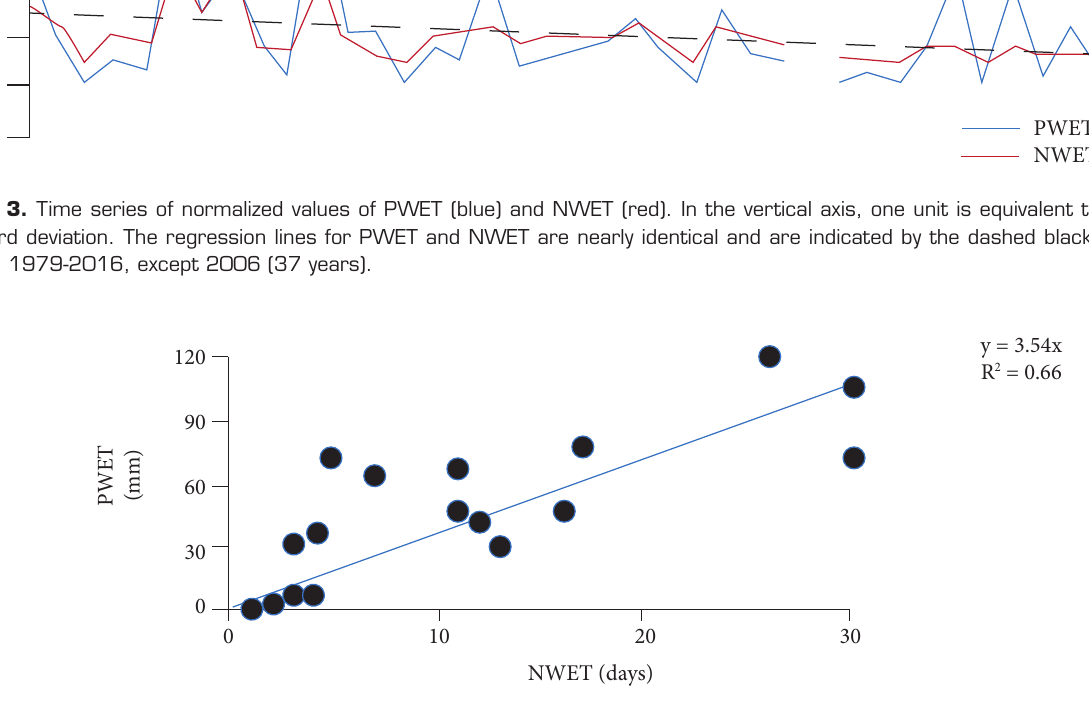
Figure 4. Dispersion diagram for the values of NWET and PWET. Each circle refers to one year. The regression line considering the intercept = 0 is drawn in blue. The regression parameters are shown at the upper-left corner. Period: 1979-2016, except 2006 (37